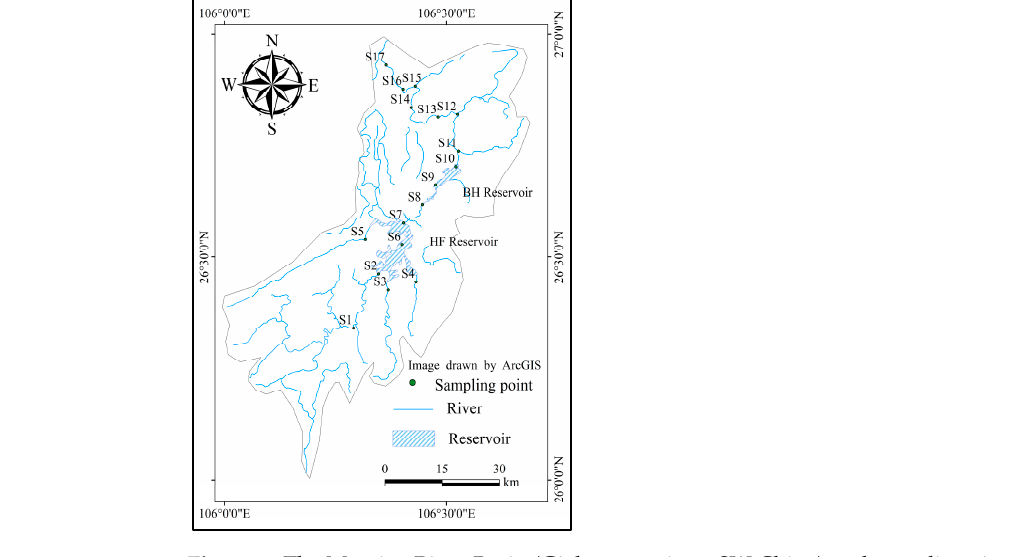
Figure 1. The Maotiao River Basin (Gizhou province, SW China) and sampling sites.